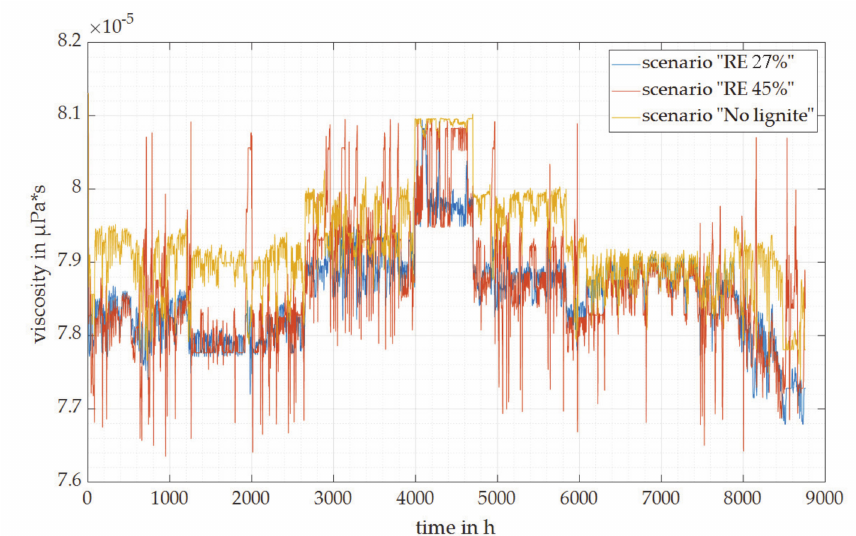
Figure 9. Viscosity variations at the trunk line entry calculated from the fed-in variable pipeline mass flow rates and CO 2 stream compositions (hourly averages) throughout one year ( = 8760 h) for the scenarios “RE 27%”, “RE 45%”, and “No lignite” (note that the figure is zoomed in on the